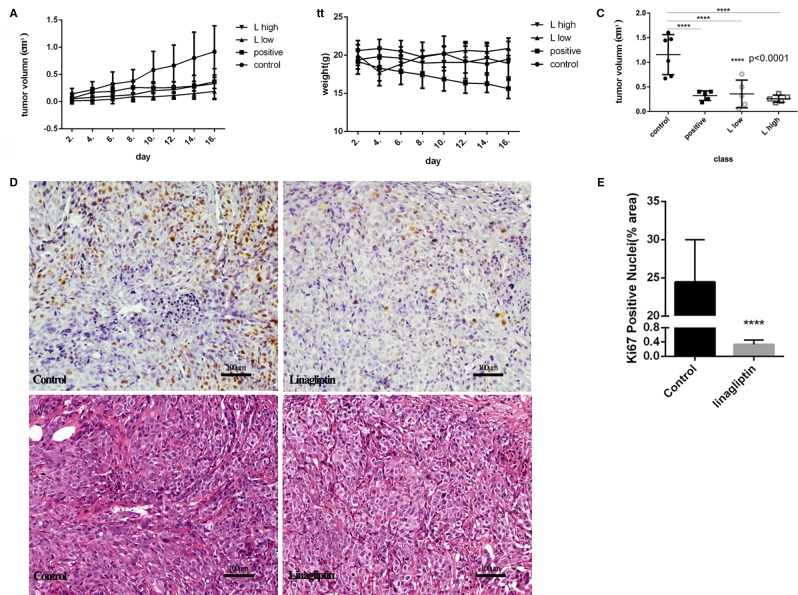
Linagliptin inhibits tumor growth in HCT116 xenograft nude mice (A): Growth curve of tumor volume in nude mice; (B): Effect of linagliptin and Cyclophosphamide treatment on body weight of nude mice; (C): Change of tumor volume from control, cyclophosphamide, 50 mg/kg and 500 mg/kg linagliptin groups; (D): Linagliptin reduced cell proliferation markers, Ki67, as determined by immunohistochemical staining (40×) and the graphs of H&E staining; (E): The statistical analysis of Ki67 in control and linagliptin treated group showed in (D).